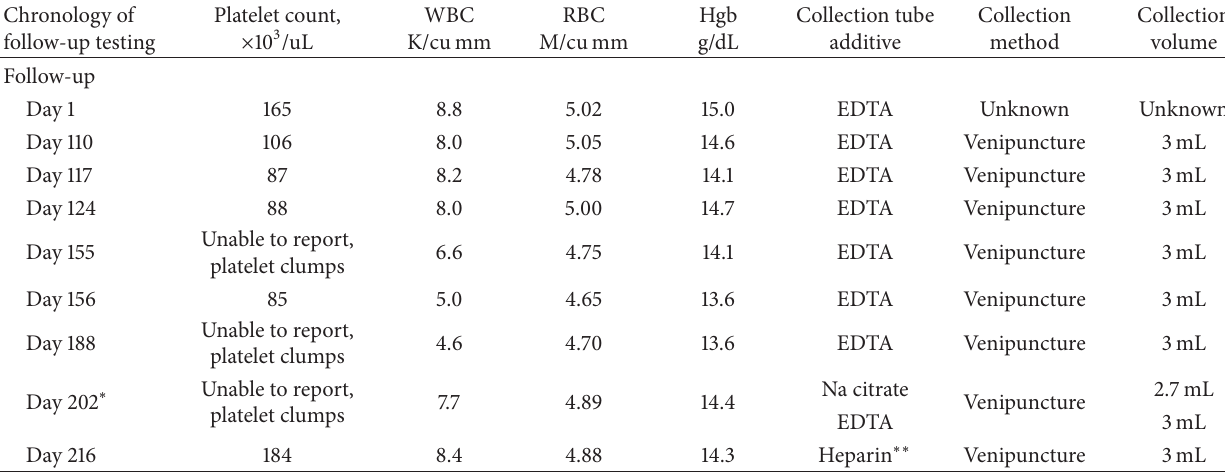
Table 1: Patient’s CBC and platelet counts over the period of care and follow-up.